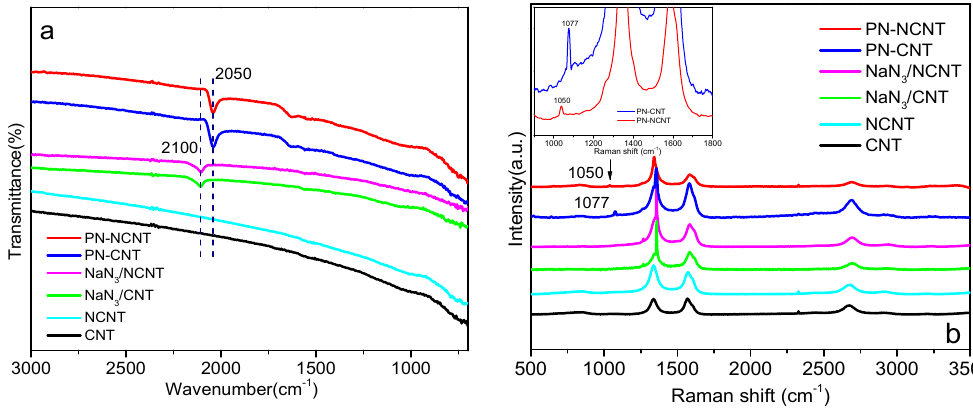
Figure 1. ( a ) ATR-FTIR and ( b ) Raman spectra of CNT, NCNT, NaN 3 / CNT, NaN 3 / NCNT, PN-CNT, and PN-NCNT (see 3. Materials and Methods for abbreviations).